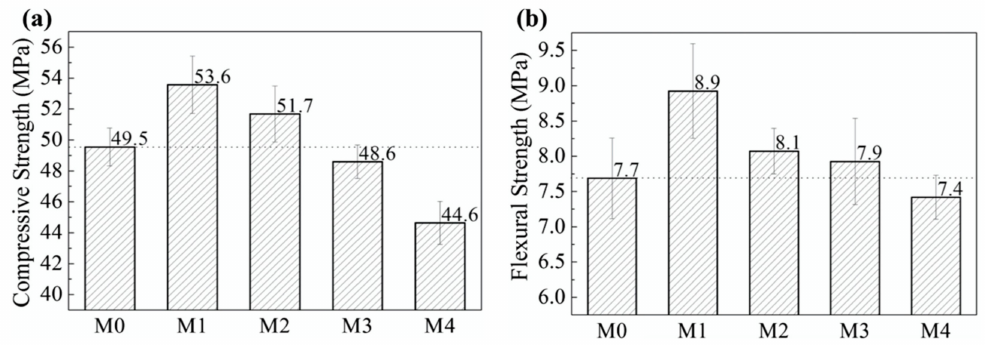
Figure 30. Experimental results of the ( a ) compressive and ( b ) flexural strengths of the GNP reinforced cement mortars. Reprinted with permission from [160]. Copyright © 2019, Elsevier